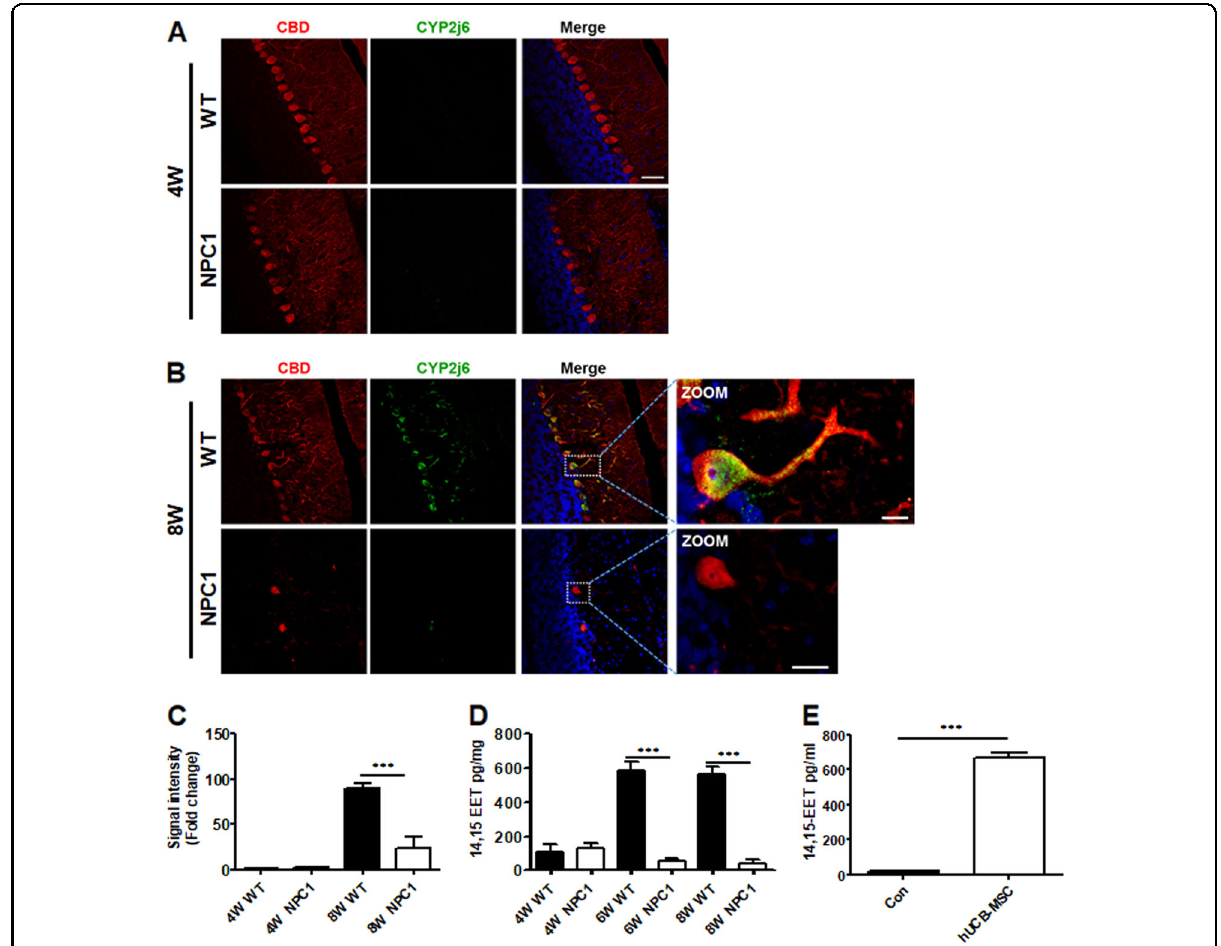
Fig. 4 Speci fi c expression of CYP2J6 in Purkinje cells in NPC1-mutant mice and 14,15-EET expression in WT, NPC1-mutant mouse cerebella, and hUCB-MSCs. a Comparison of immunocytochemistry analysis of the co-localization of CYP2J6 (CYP2J6; green) with Purkinje cells (calbindin; red) at 4 weeks of age and b 8 weeks of age in WT and NPC1-mutant mouse cerebella (NPC1). c Relative expression of CYP2J6 shows decreased expression of CYP2J6 at 8 weeks of age in NPC1-mutant mouse cerebella. d Through ELISA, 14,15-EET was analyzed at 4 weeks, 6 weeks, and 8 weeks of age from WT and NPC1-mutant mouse cerebella. e 14,15-EET in the free media and the supernatants of hUCB-MSC culture media were collected and compared by ELISA. All data represent the mean ± SD. Scale bars = 50 μ m ( a , b share the same scale bar; c , d share the same scale bar). *** P <